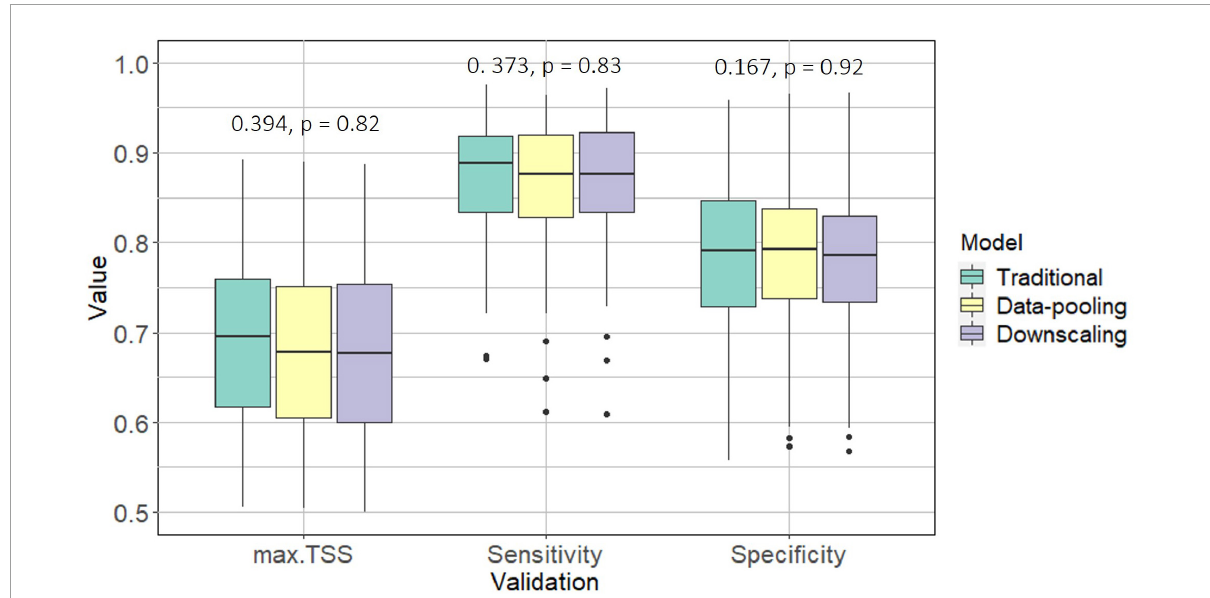
FIGURE1 Boxplots representing the distribution of values obtained for max.TSS, max.Sensitivity, and max.Specificity for all bird species (those with a max.TSS > 0.4) and each of the considered models: traditional, data-pooling and downscaling. For each metric the Kruskall-Wallis statistic and its associated p -value are shown, with “*” marking significant differences between models.